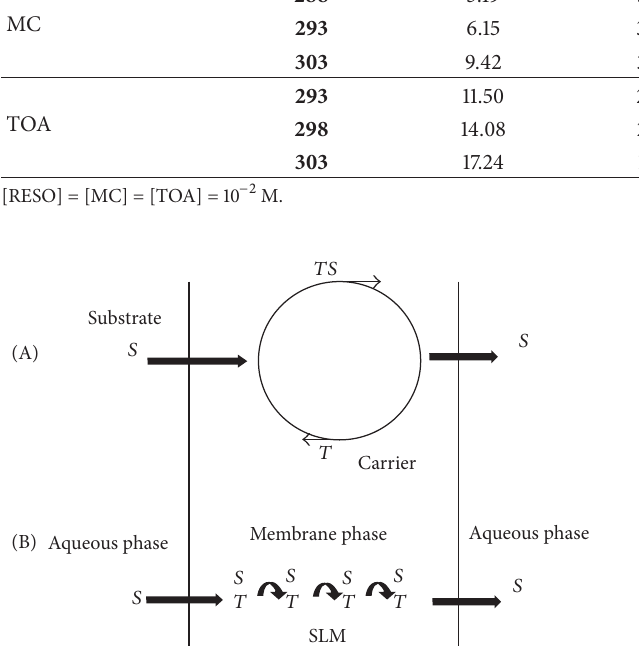
and 𝐷 ∗ and activation parameters E ass